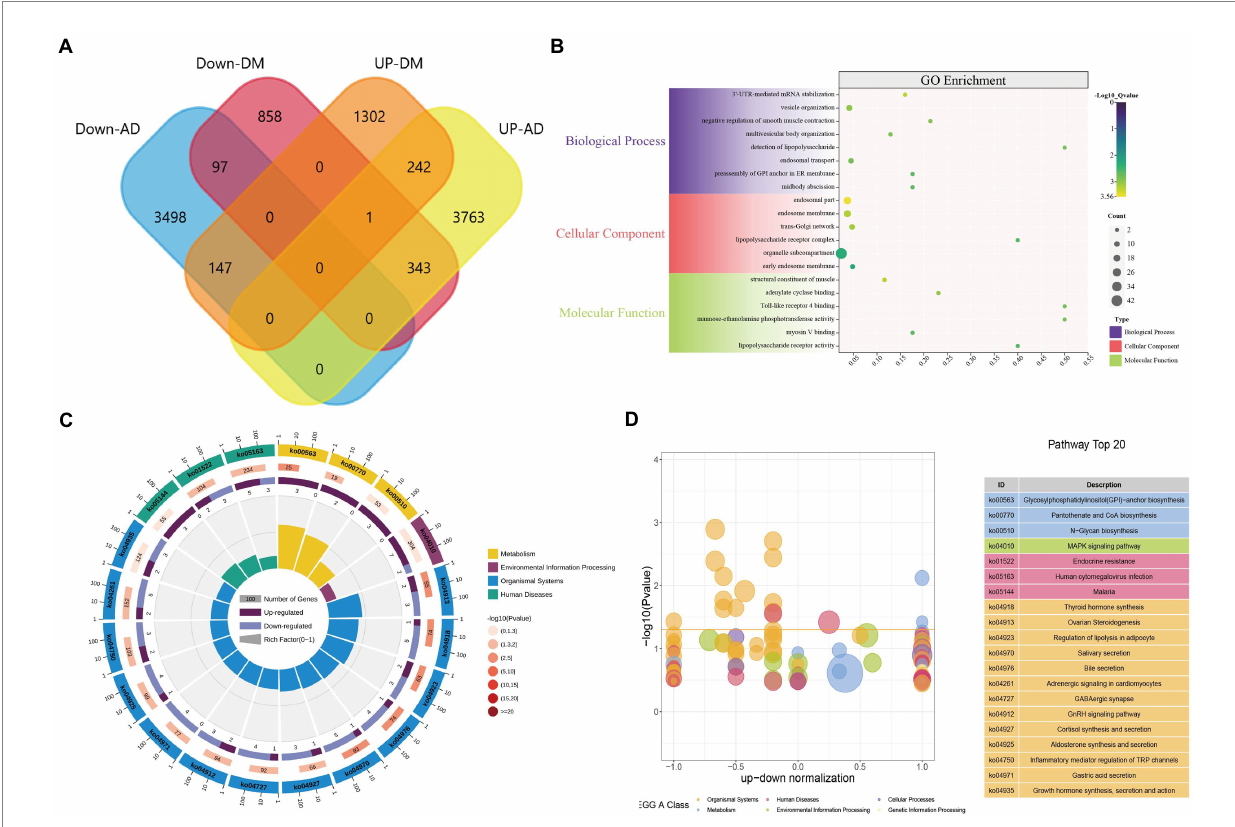
FIGURE 4 DEGs enrichment analysis results. (A) The two datasets showed an overlap of 339 DEGs, (B) The enrichment analysis results of GO, and (C–D) The enrichment analysis results of the KEGG Pathway. Adjusted p -value <0.05 was considered